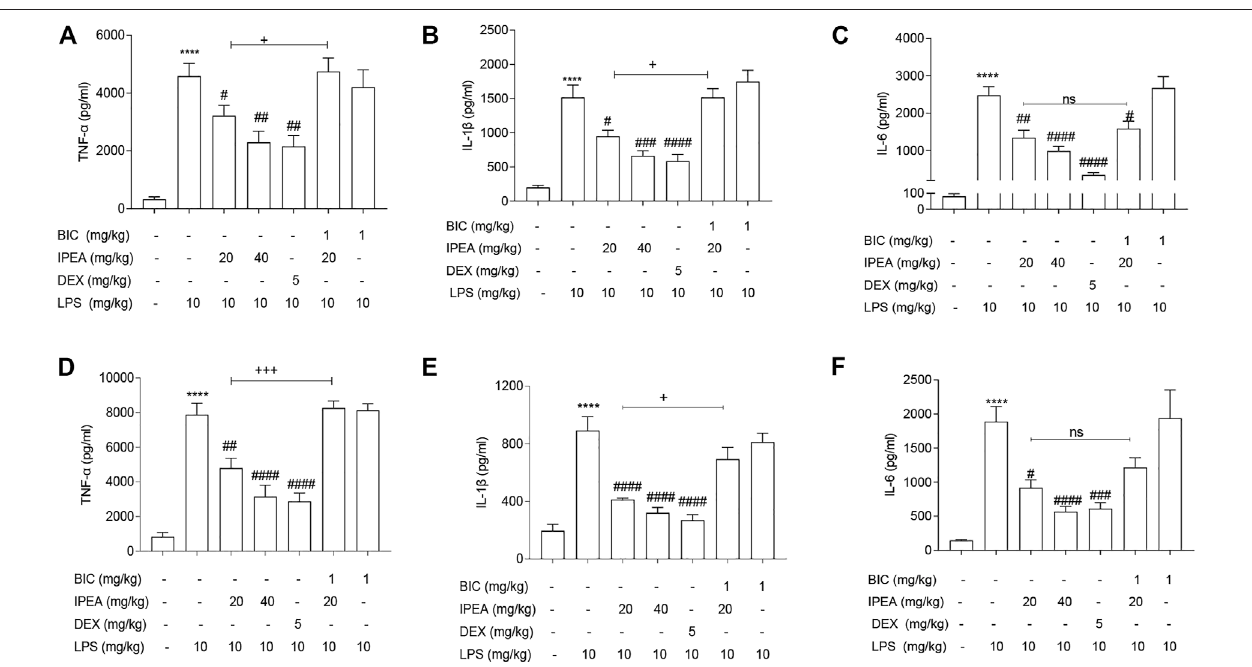
FIGURE 6 | IPEA exerts anti-in fl ammatory effect via GABAAR in septic mice. The protein expression levels of TNF- α , IL-1 β and IL-6 in serum (A – C) , and in the liver (D – F) weredetermined byELISAaccordingtomanufacturer ’ sinstructions. MicewerepretreatedwithBIC(1 mg/kg)for30 min, followedbyIPEAadministration (20and 40 mg/kg, i. p.). After 1 h-IPEA treatment, mice were injected with LPS (10 mg/kg, i. p.). After 12 h, mice liver tissue was obtained, and the serum was collected by centrifuging at 4 ° C, 4,000 rpm for 10 min. The liver tissue was treated with animal tissue homogenizer, and then centrifuged at 4 ° C, 1,000 rpm for 20 min. The supernatant was obtained and quantitated by BCA kit. DEX (dexamethason, 5 mg/kg) was used as positive control. One-way ANOVA followed Tukey test was used for data analysis. The data were expressed as the means ± SEM (n (cid:2) 6 – 7). * p < 0.05, ** p < 0.01, *** p < 0.001, **** p < 0.0001 vs the control group; # p < 0.05, ## p < 0.01, ### p < 0.001,#### p < 0.0001vsLPStreatmentgroup;+ p < 0.05,++ p < 0.01,+++ p < 0.001,comparedbetweenIPEAgroupandBIC+IPEAgroup.ns,notsigni fi